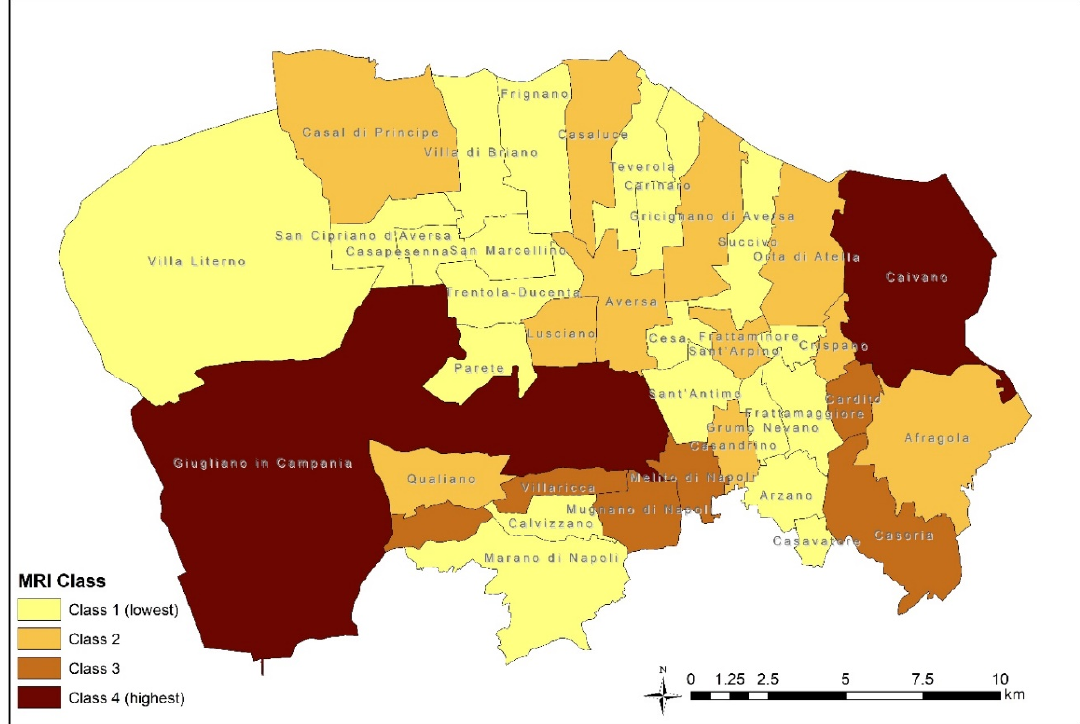
Figure 5. Distribution of Municipal Risk Index (MRI) classes by municipality.